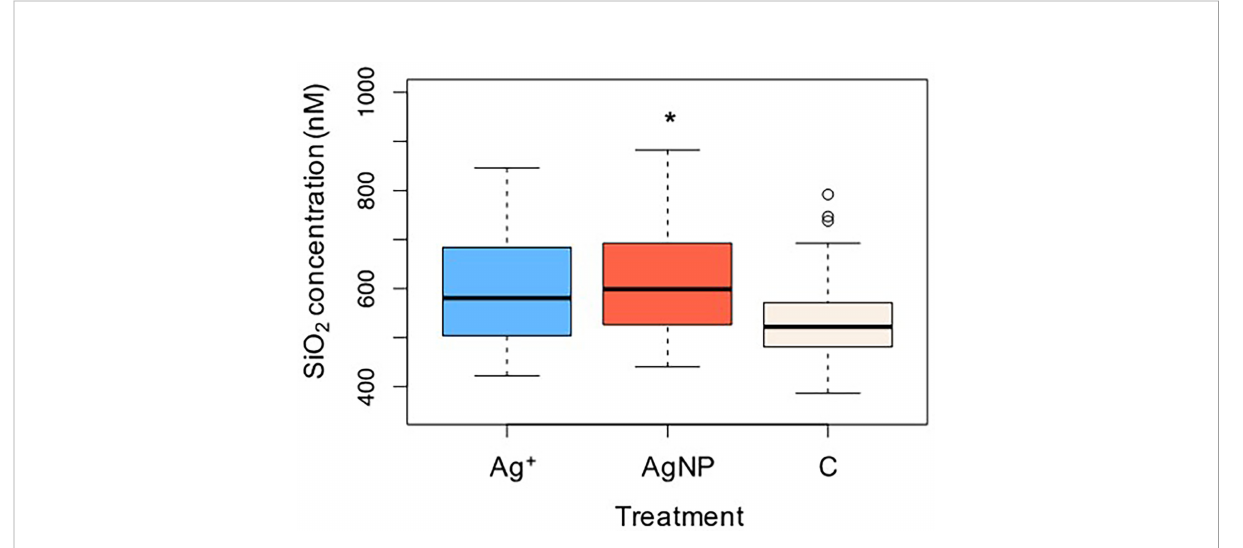
FIGURE 6 Changes in silicate as an effect of Ag + and AgNPs addition. Asterisks above boxplots indicate levels of signi fi cance